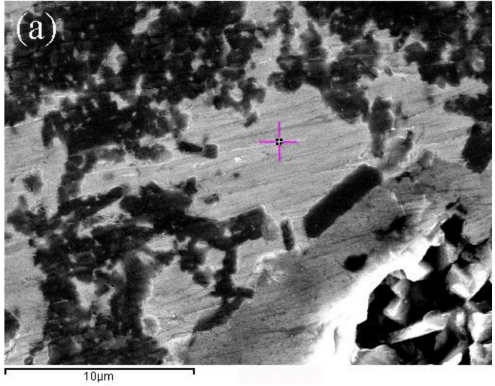
Figure 8. SEM micrographs of C/C–Al–Cu: ( a ) Conductive phase; and ( b ) conductive model.